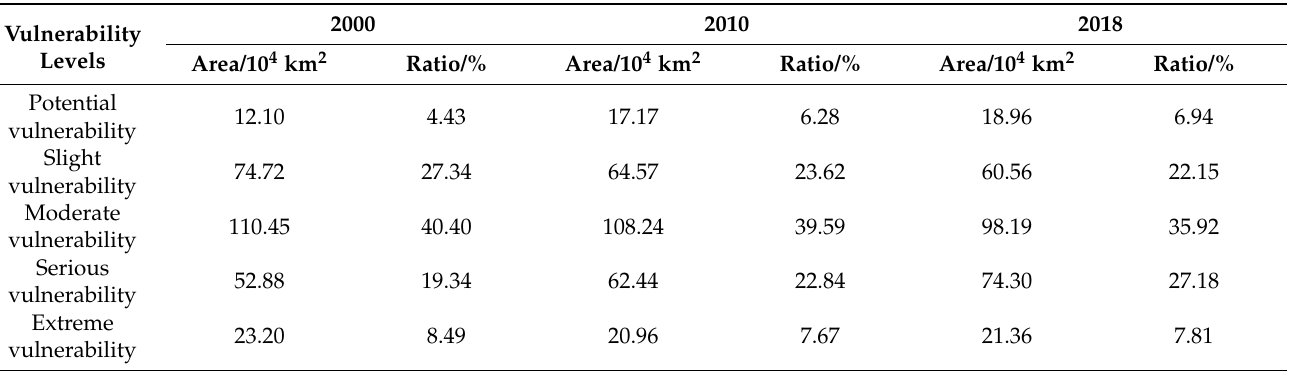
Figure 2. Vulnerability levels in 2000 ( a ), 2010 ( b ), and 2018 ( c ), and change from 2000 to 2018 ( d ) on the Qinghai-Tibet Plateau. Table 1. Areas and ratios of different remote sensing ecological vulnerabilities on the Qinghai-Tibet Plateau in 2000, 2010, and 2018.